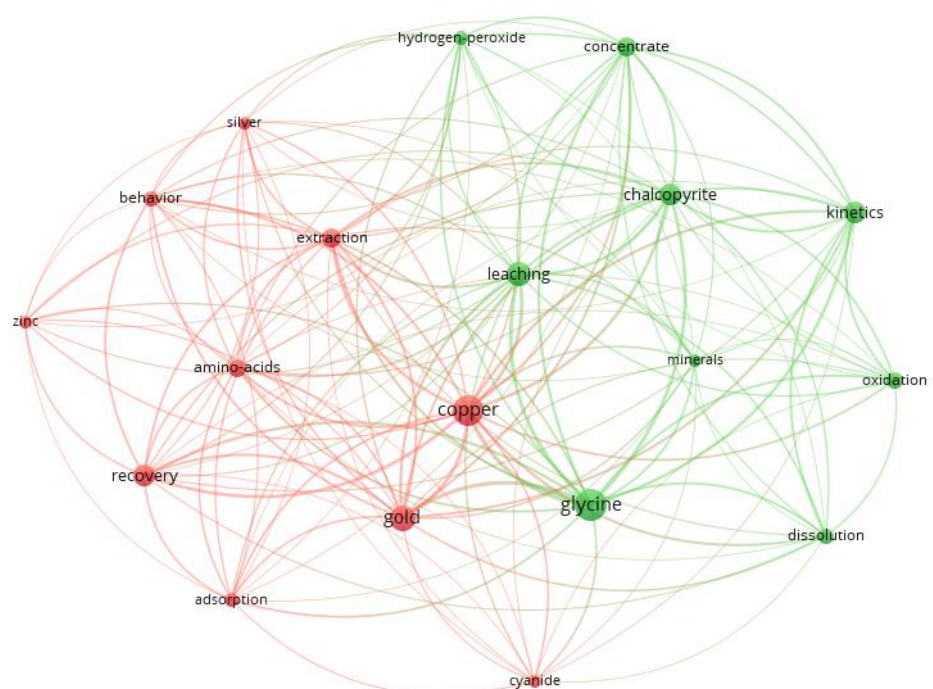
Figure 2. Keywords associated with research in glycine: cluster 1 (red) and cluster 2 (green).